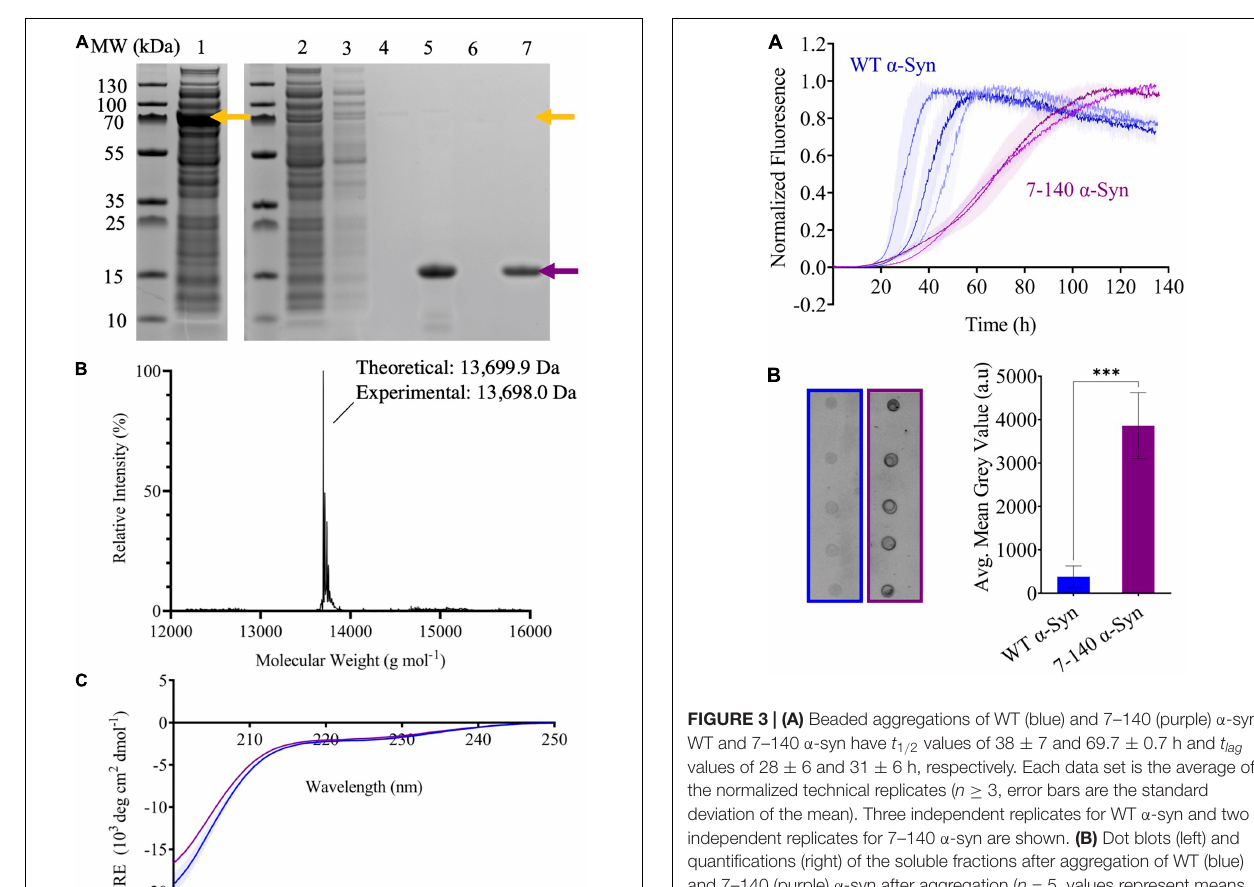
taken between 200 and 250 nm, scanning speed 50 nm min −